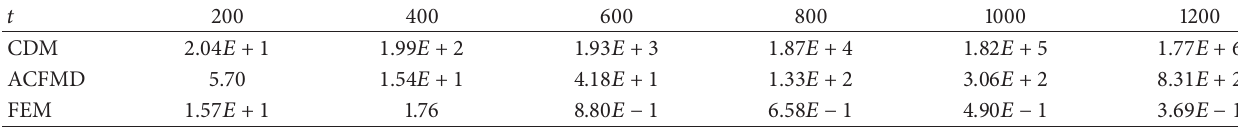
Table 1: The numerical solutions at different time for (1) with 𝑏 = 1.01 .